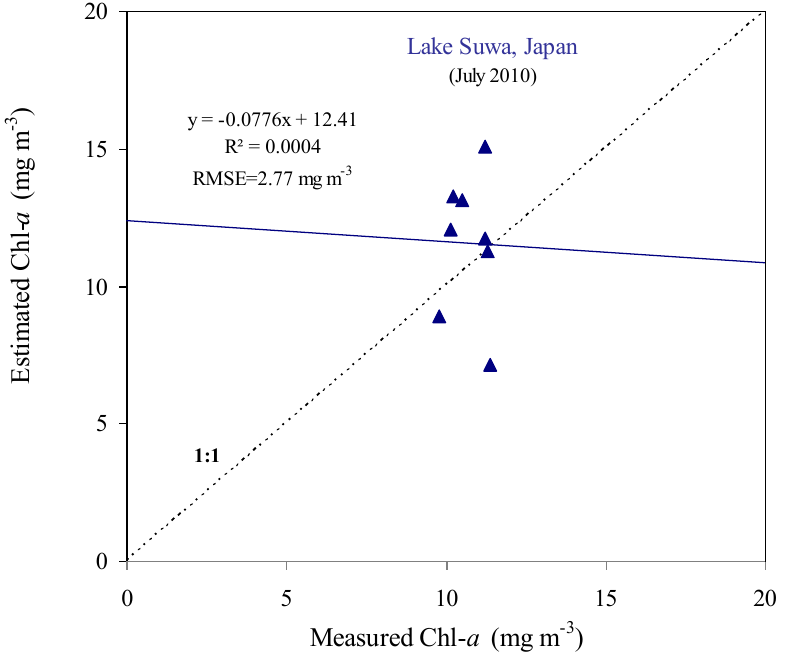
Figure 6. Comparison of the measured and estimated Chl- a by the SAMO-LUT for Lake Suwa, Japan.